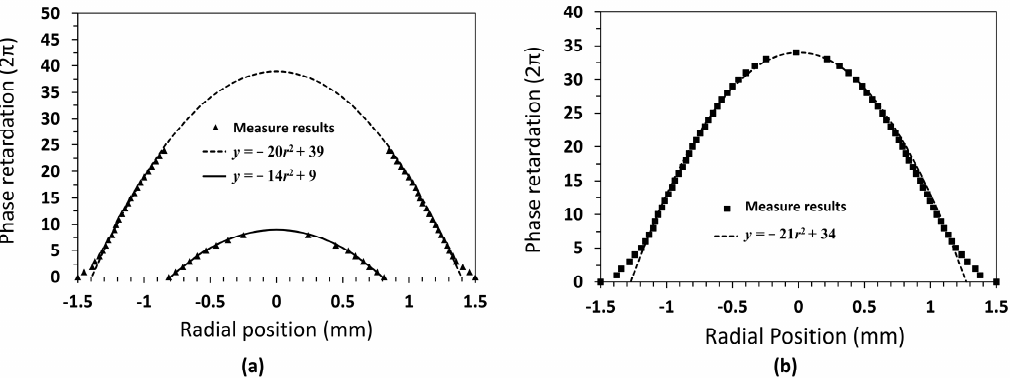
Figure 9. The radial phase retardation profiles of the TLCL lens with various operating voltages: ( a ) 50 V rms ; ( b ) 100 V rms . The dash curves denote the quadratic curve fitting.